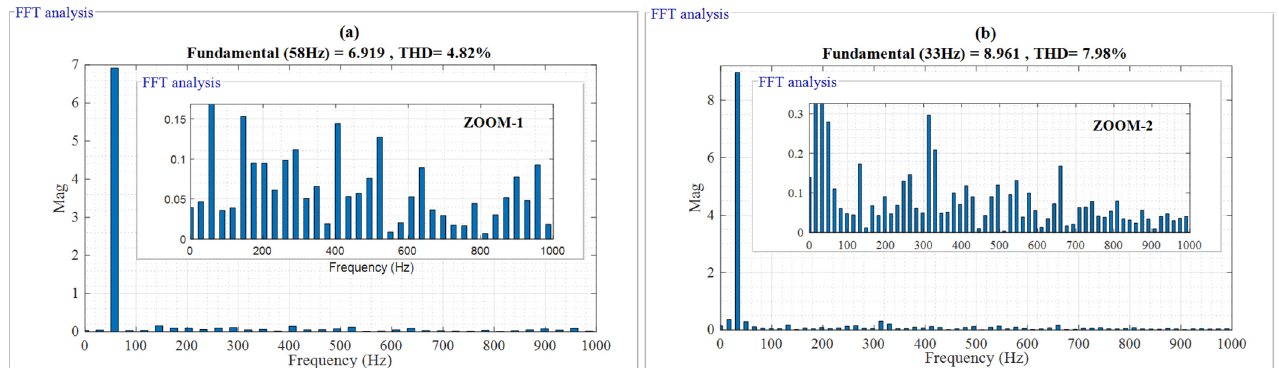
Figure 16. Stator ( a ) and rotor ( b ) THDs of an ACO-DTC.